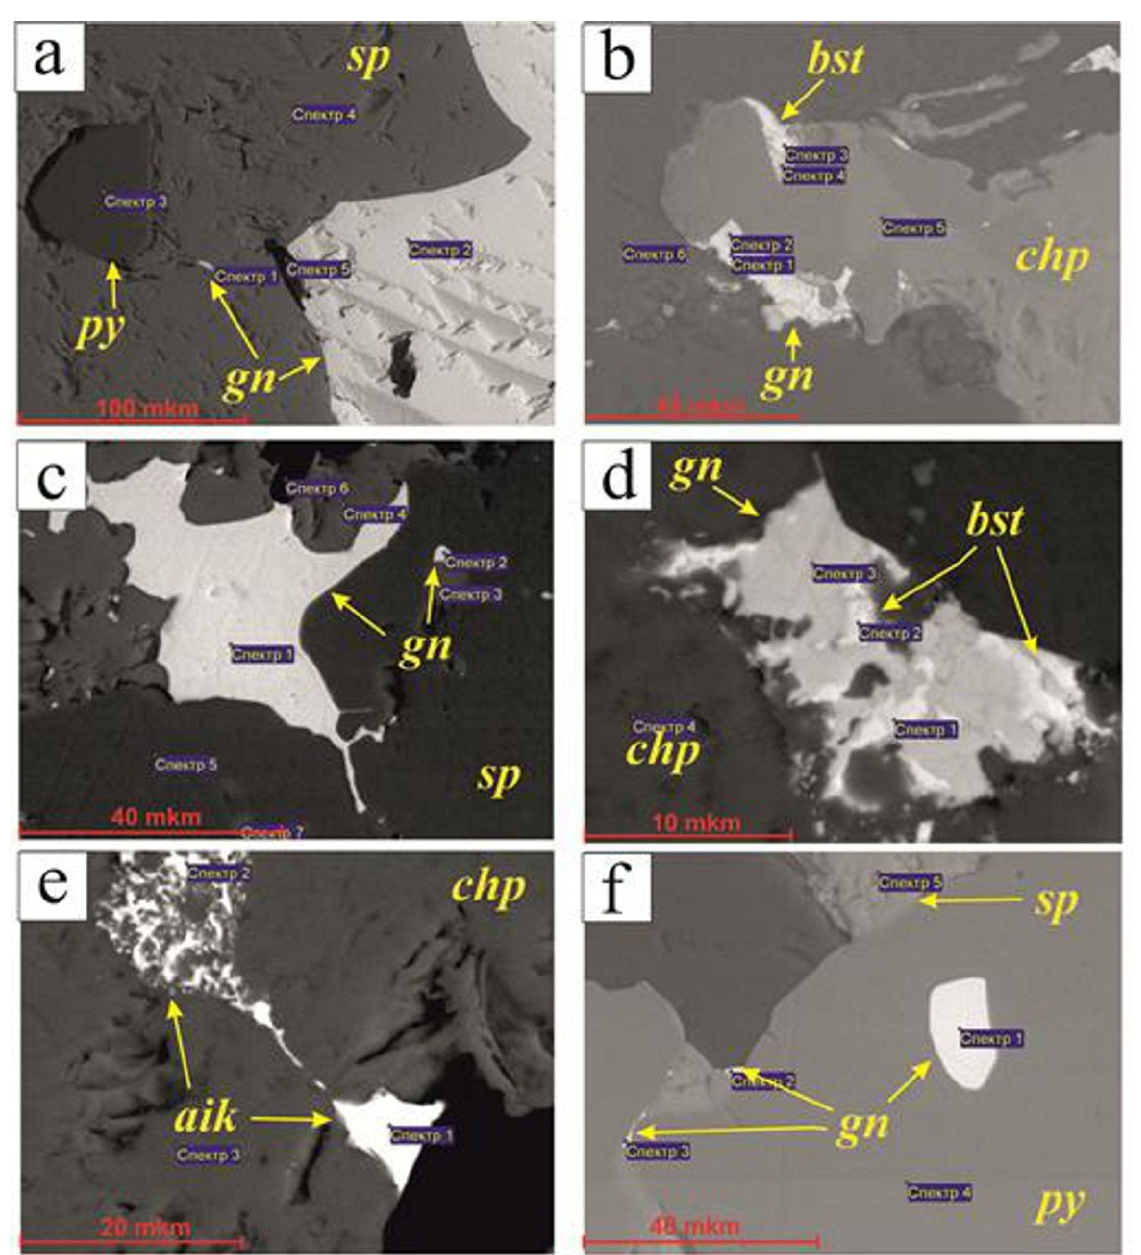
Figure 4. Mineralogy and mineral microinclusions in the ores of typical Rudny Altai deposits, after [47]. ( a ) Typical assemblage of galena and pyrite (py), Ridder–Sokolny deposit; ( b ) aggregates of galena (gn) and bismuthite (bst) with chalcopyrite (chp), Artemiev deposit; ( c ) galena microcrystal in sphalerite (sp), Artemiev deposit; ( d ) galena microinclusion, with bismuthite and Ta, W impurity, Artemiev deposit; ( e ) aikinite (aik) strings in chalcopyrite, Ridder–Sokolny deposit; ( f ) galena (gn) microinclusion in pyrite, Ridder–Sokolny deposit. Mineralization occurs as seven 10–300-m-wide and 12-m-thick lens-shaped orebodies The ores contain on average 1.12 wt% Zn, 0.45 wt% Pb, 0.47 wt% Cu, 14.38 ppm Ag, arranged in a 1000 m long chain at the boundary between the two different formations. and 1.5 ppm Au, as well as impurities of 30 ppm Bi, 32 ppm Cd, 1. ppm Se, 130 ppm Te, The ores show prominent vertical zonation (top to bottom) of barite-base metal, pyrite-base metal, Cu-Zn, and Cu-sulfide zones with the respective assemblages of (i) Pb-Zn minerals and minor amounts of barite, Au, Ag, Cd, Hf, Sb, As, Te, etc., in the hanging wall and (ii) Cu-Bi- pyrite in the footwall of the